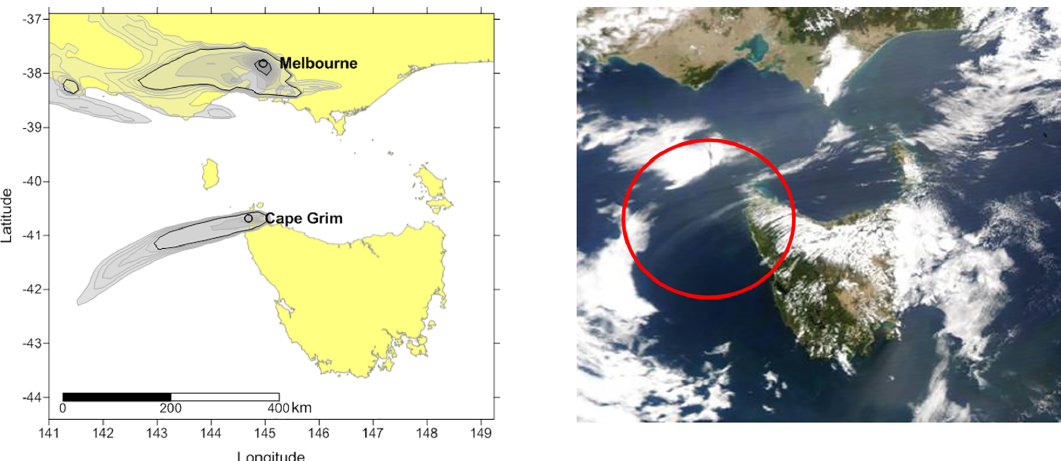
Figure 3. Model output of BC (left) on 23 February, with a MODIS True Color image of the same